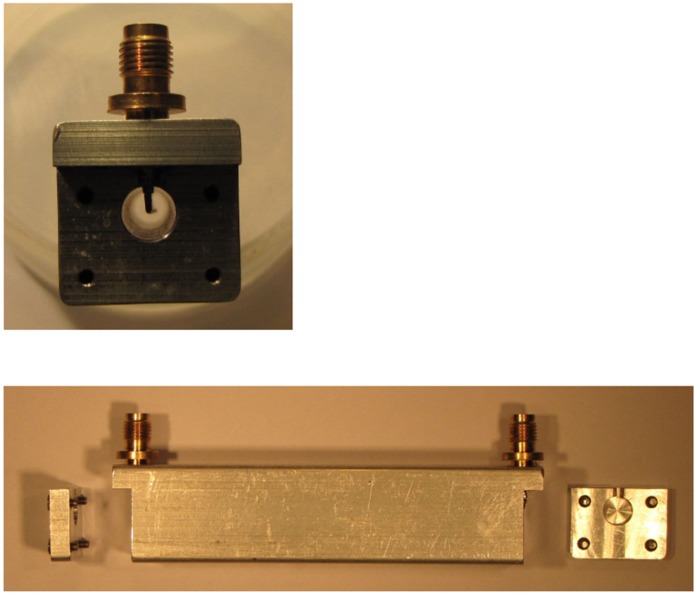
Picture of a monolitic aluminum cell.With its perpendicular SMA connectors this 82 mm inner length construct is the longest possible cell allowing TEM || B operation in our wide-gap magnet.